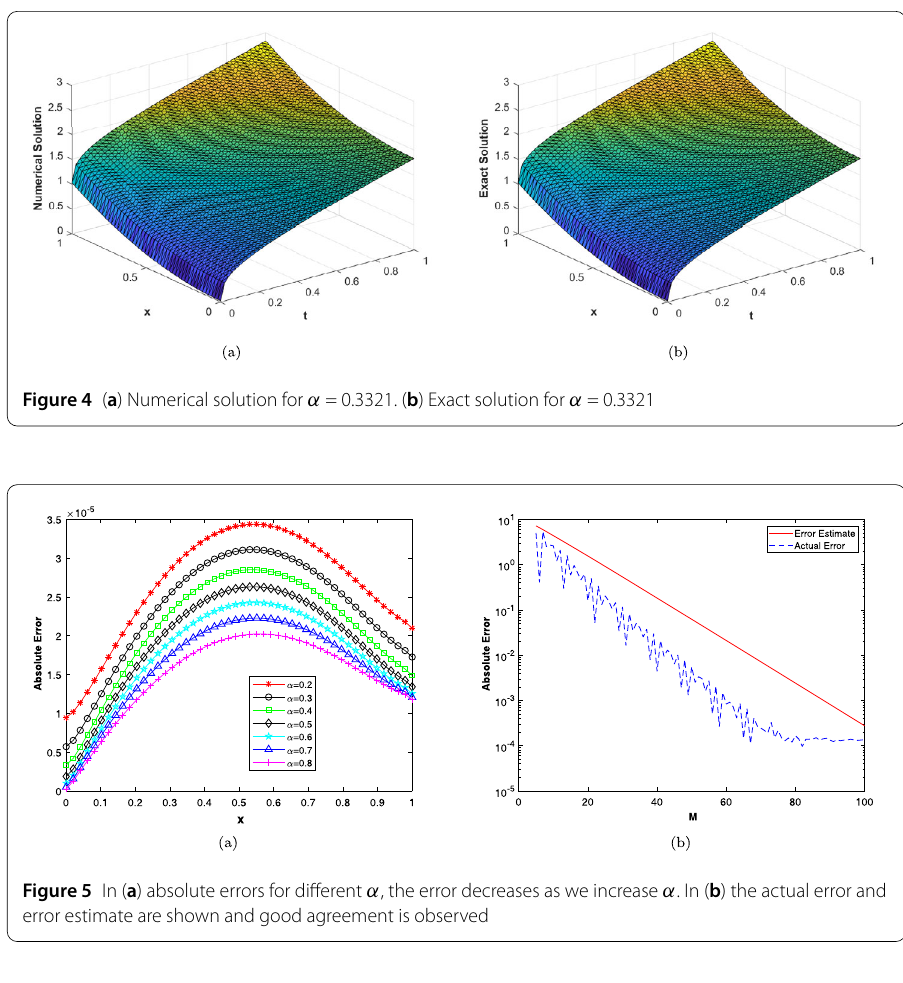
the actual error and error estimates are shown, which shows good agreement